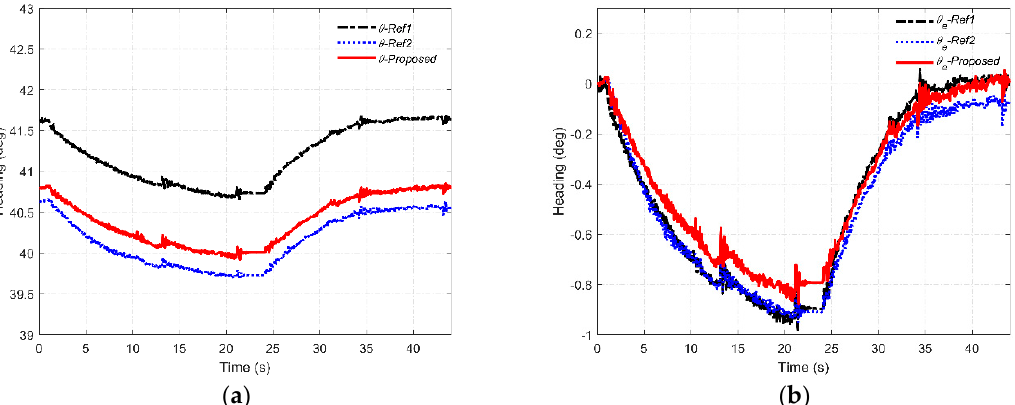
Figure 10. Comparison of heading and heading error with three controllers: ( a ) Comparison of heading; ( b ) Comparison of heading error.